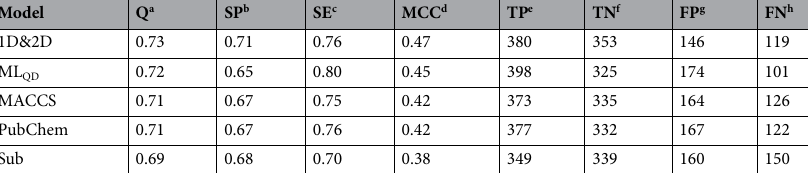
Table 7. Evaluation of classification trees based on interpretable fingerprints and molecular descriptors for the classification of UV–Vis absorption spectra of organic molecules in test set I. a Overall predictive accuracy for the training set in OOB estimation. b Overall predictive accuracy (test set I). c Specificity (test set I). d